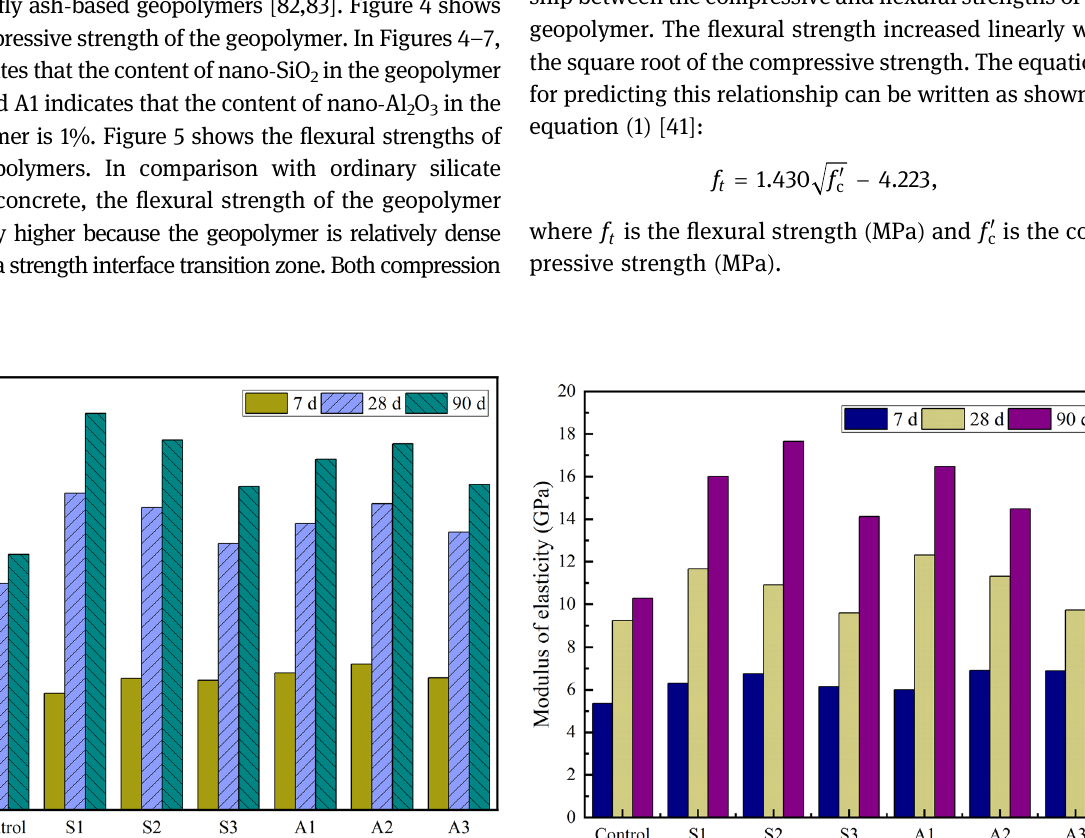
Figure 6: Relationship between compressive strength and fl exural strength of geopolymer pastes [ 41 ]